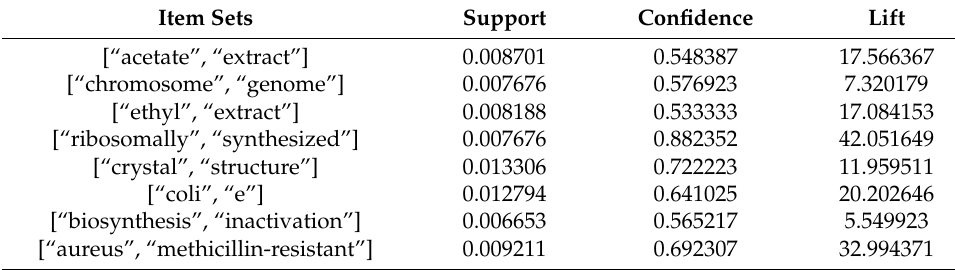
Table 7. Sample item sets of streptomycin dataset.